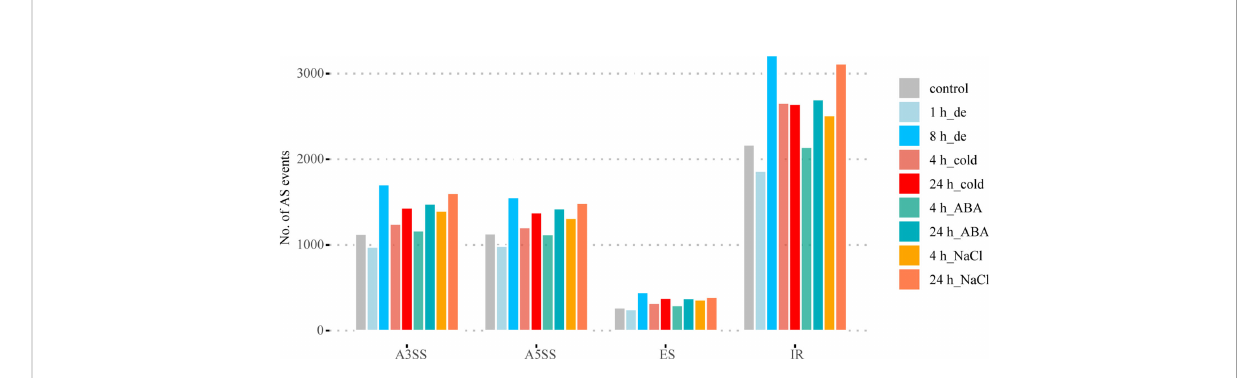
FIGURE 1 AS landscapes of control and treatments with dehydration, cold, ABA, and NaCl at two different time points in B. napus. A3SS, alternative 3 ′ splice site; A5SS, alternative 5 ′ splice site; ES, exon skip; IR, intron